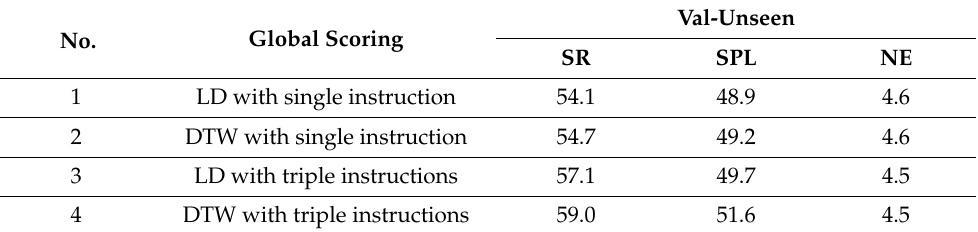
Table 3. Comparison among different global scoring methods.